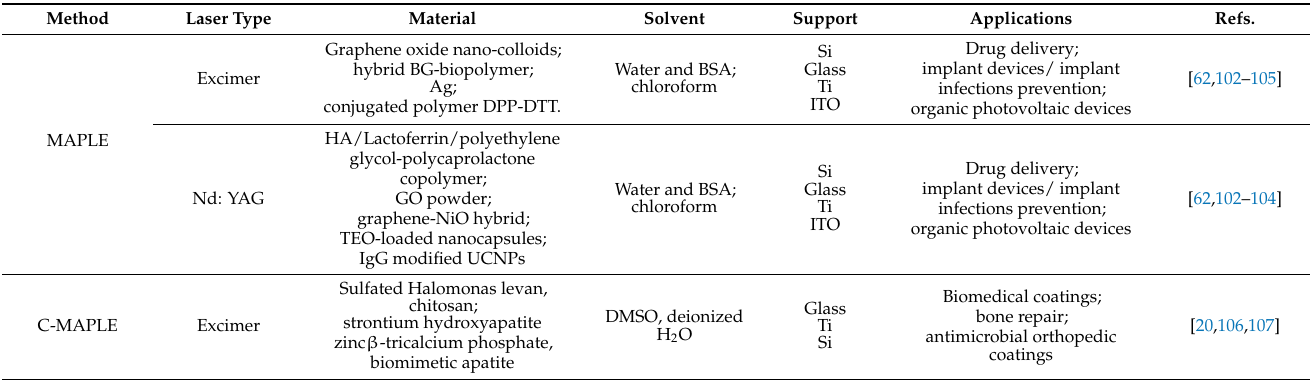
Table 3. Examples of biomaterials applied in surface functionalization with MAPLE and C- MAPLE